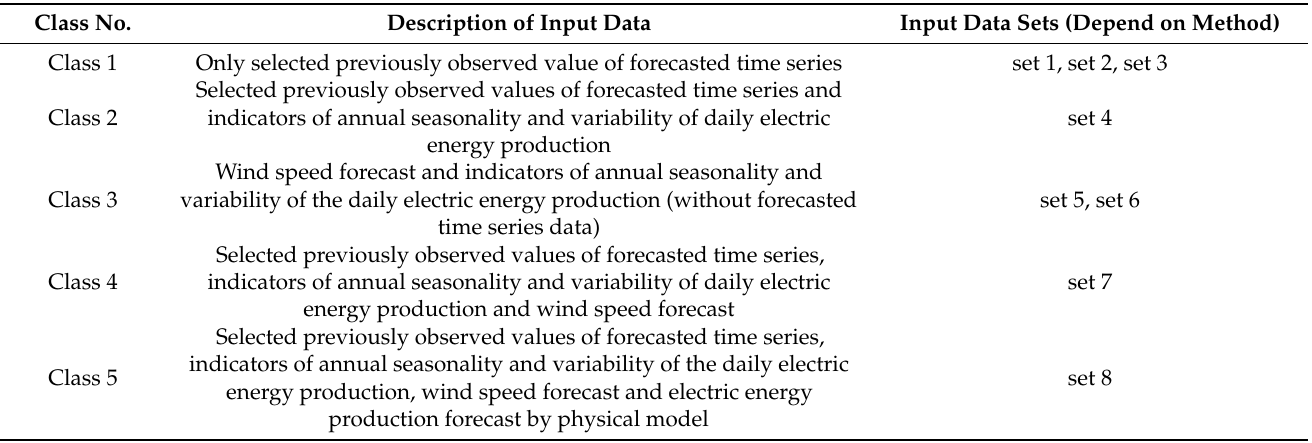
Table 6. Tested input data sets for each class forecast.